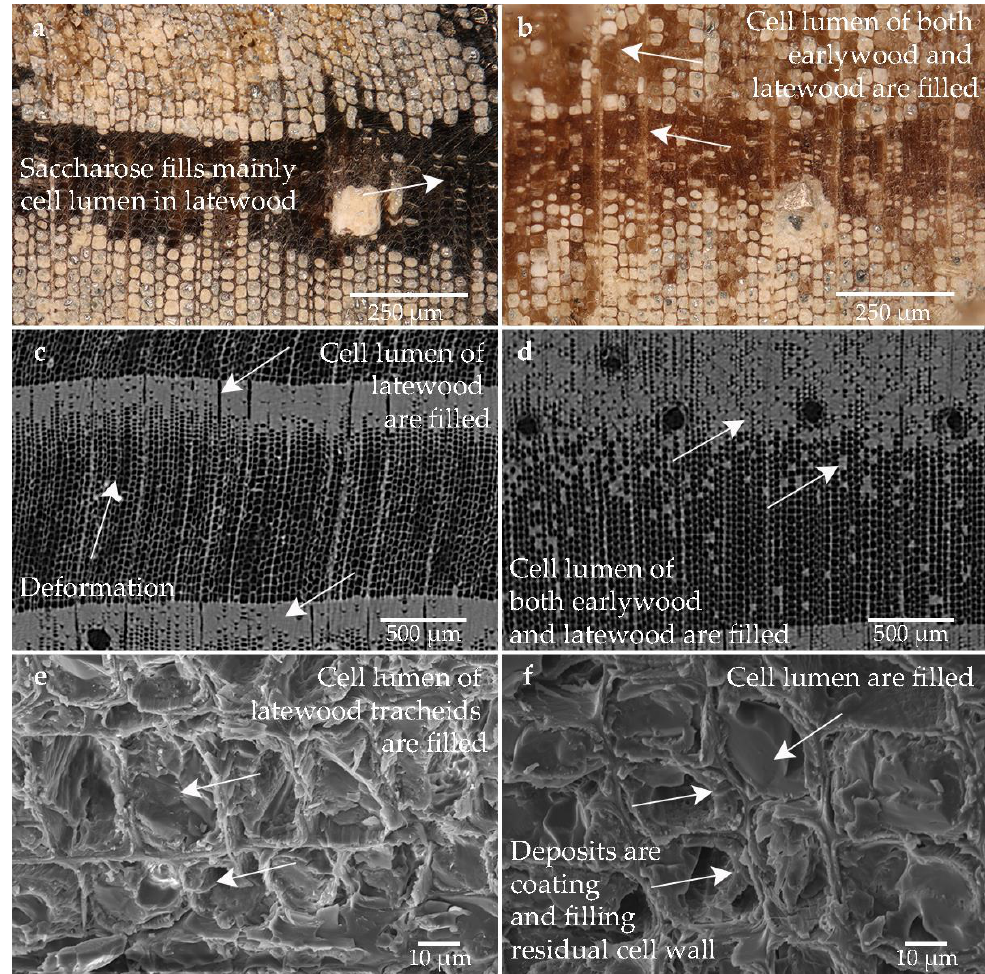
Figure 9. Microscopic wood structure of sample conserved with saccharose (Pi1-Sac) ( a ) RLM image from the heavily degraded area; ( b ) RLM image from the low degraded area; ( c ) CT image of the cross section of the heavily degraded sample; ( d ) CT image of the cross section of the low degraded sample; ( e ) SEM image of the latewood tracheids; ( f ) SEM image of the earlywood tracheids in the heavily degraded area.